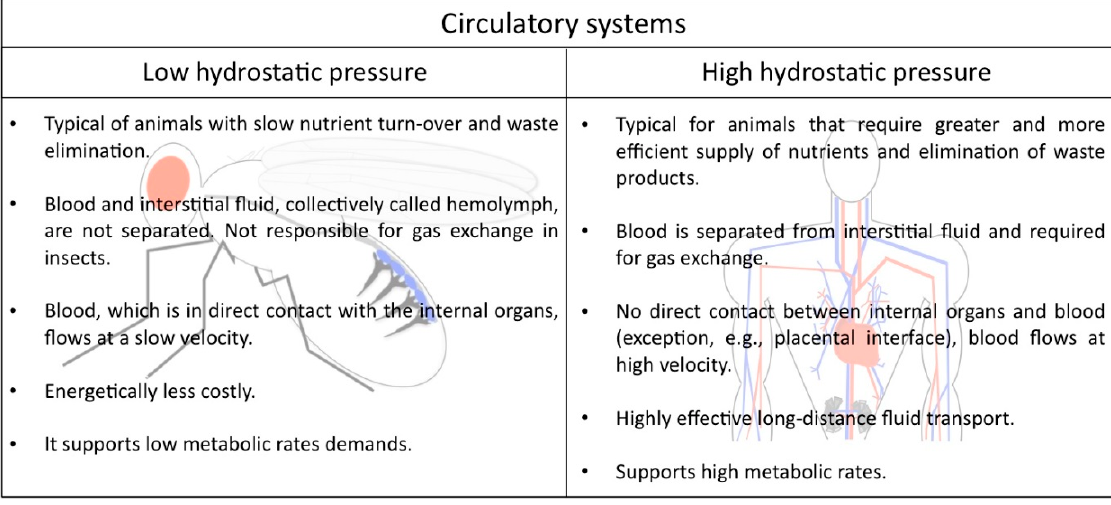
Figure 1. Comparison of the circulatory system in Drosophila and humans.